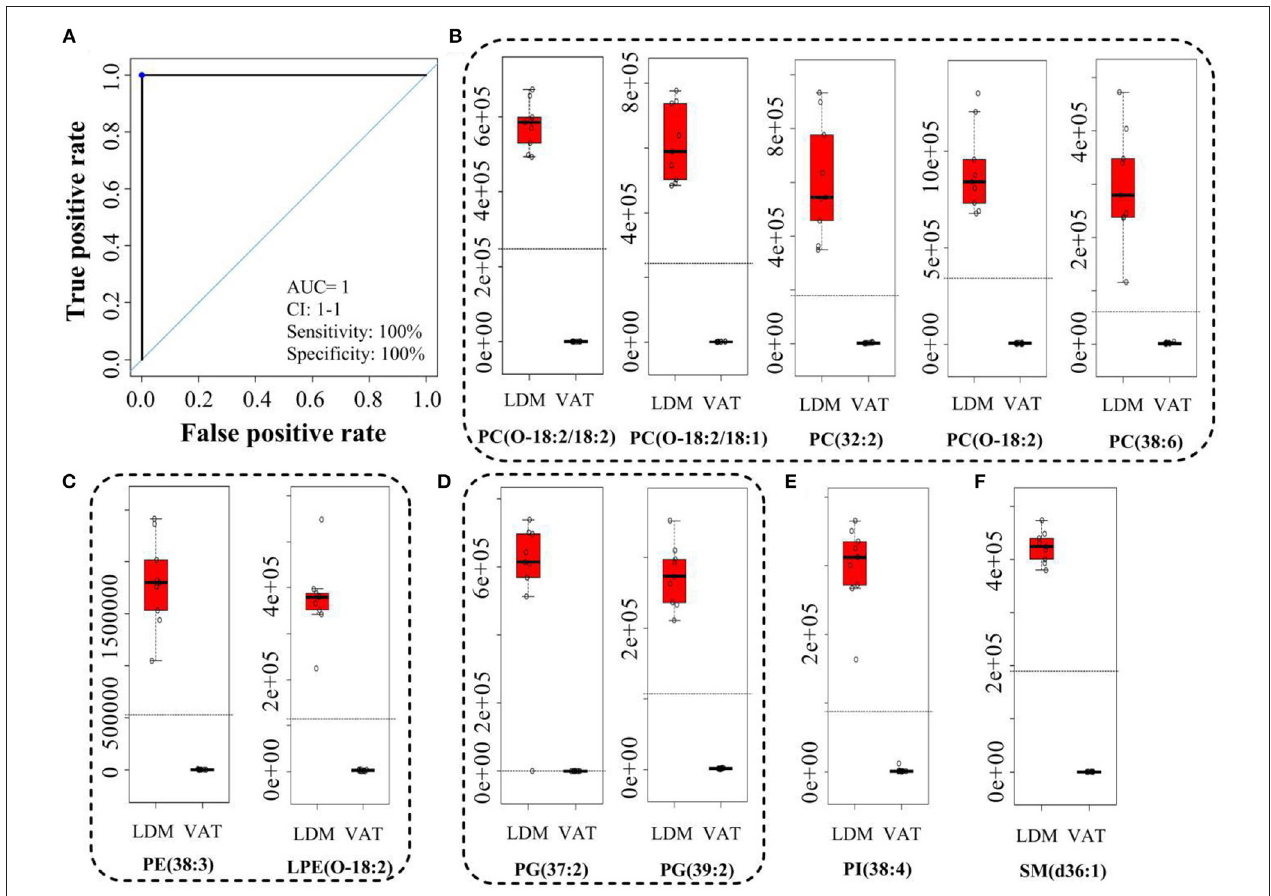
FIGURE 4 | Receiver operating characteristic curve and normalized intensity for potential lipid markers. (A) Receiver operating characteristic curve of (B–F) . (B–F) Normalized intensity for potential lipid markers in LDM and VAT. AUC is the area under the ROC curve; CI 1-1 is the lower and upper limit of the AUC confidence